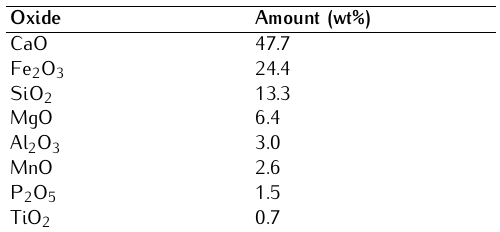
Table 1. Example of BOF slag chemical composition, expressed as oxides